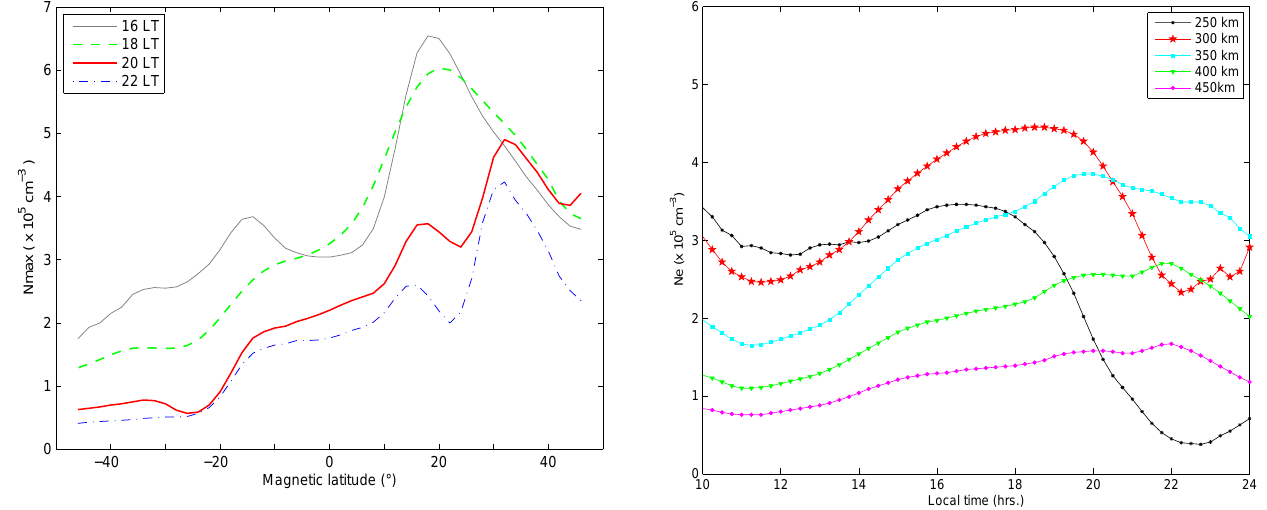
Fig. 8. Latitudinal variation of N max at 16:00, 18:00, 20:00 and 22:00LT, obtained using normal drift and MU winds. Fig. 9. Local time variation of electron density, at different altitudes corresponding to 38 ◦ N magnetic latitude. The simulations are done using normal drift and MU